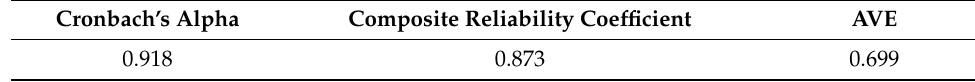
Table 2. The reliability and validity findings of the